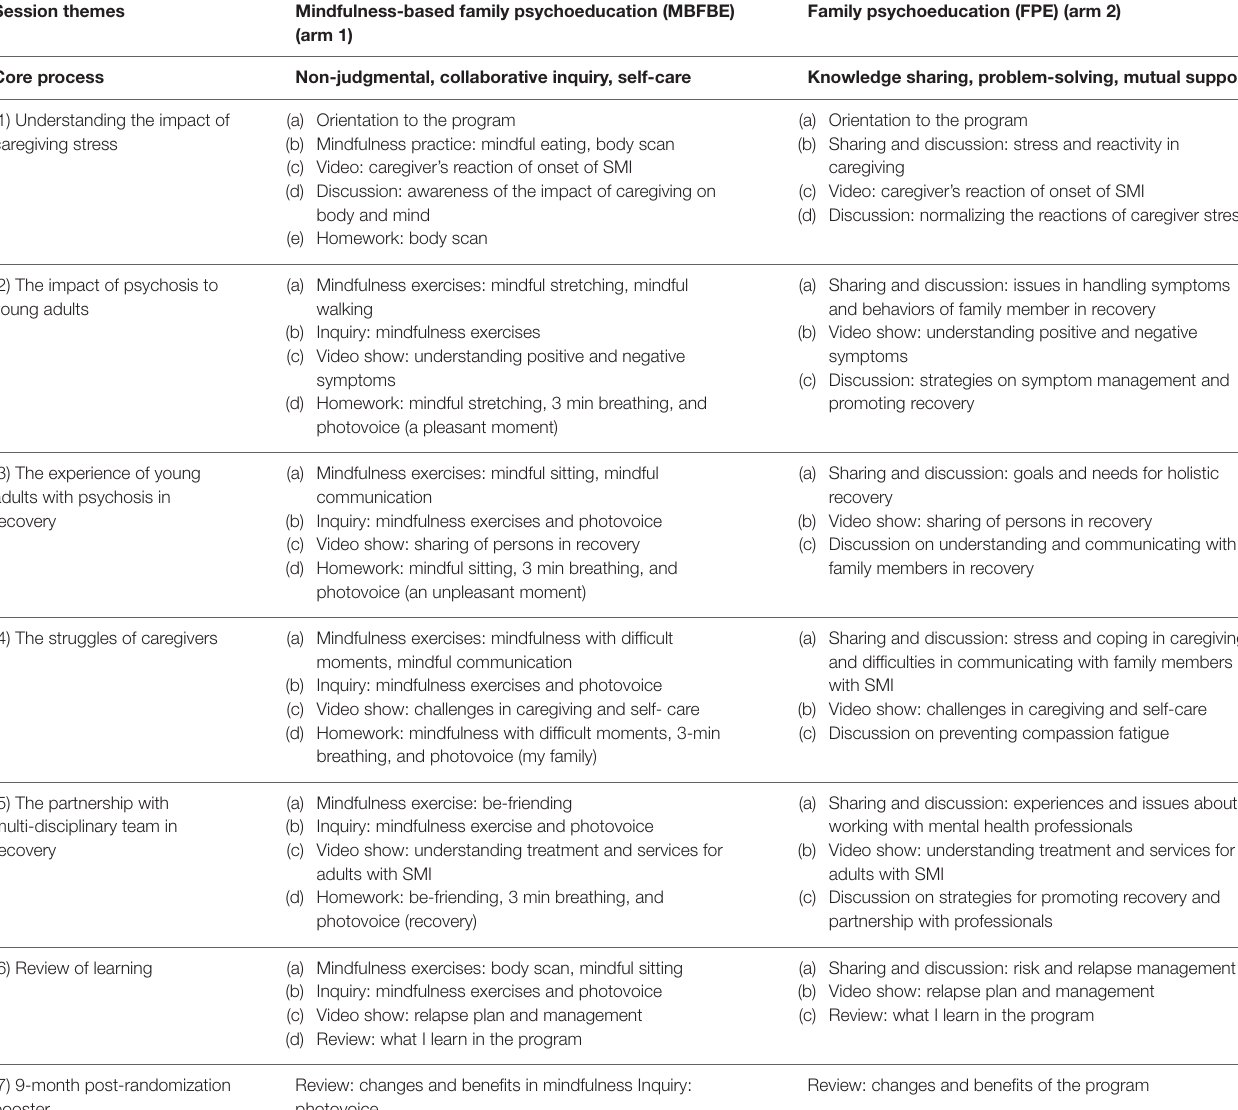
TABLE 1 | Proposed intervention program outline: content of mindfulness-based family psychoeducation (MBFPE) (arm 1) and family psychoeducation (FPE) (arm 2). Session